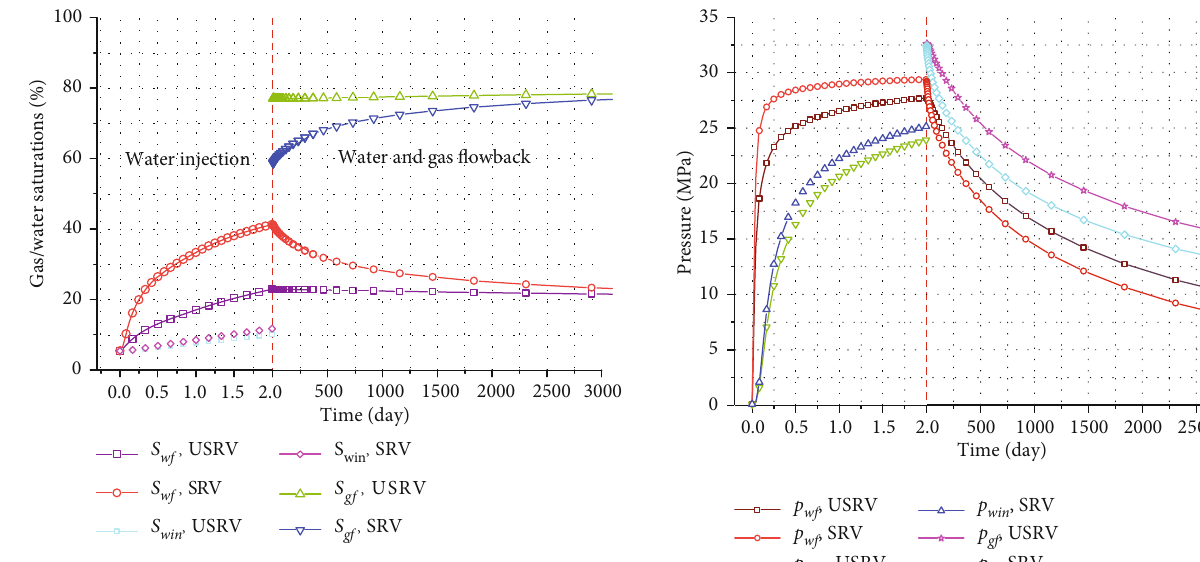
Figure 7: Evolution of average water saturation in the SRV and USRV regions. Figure